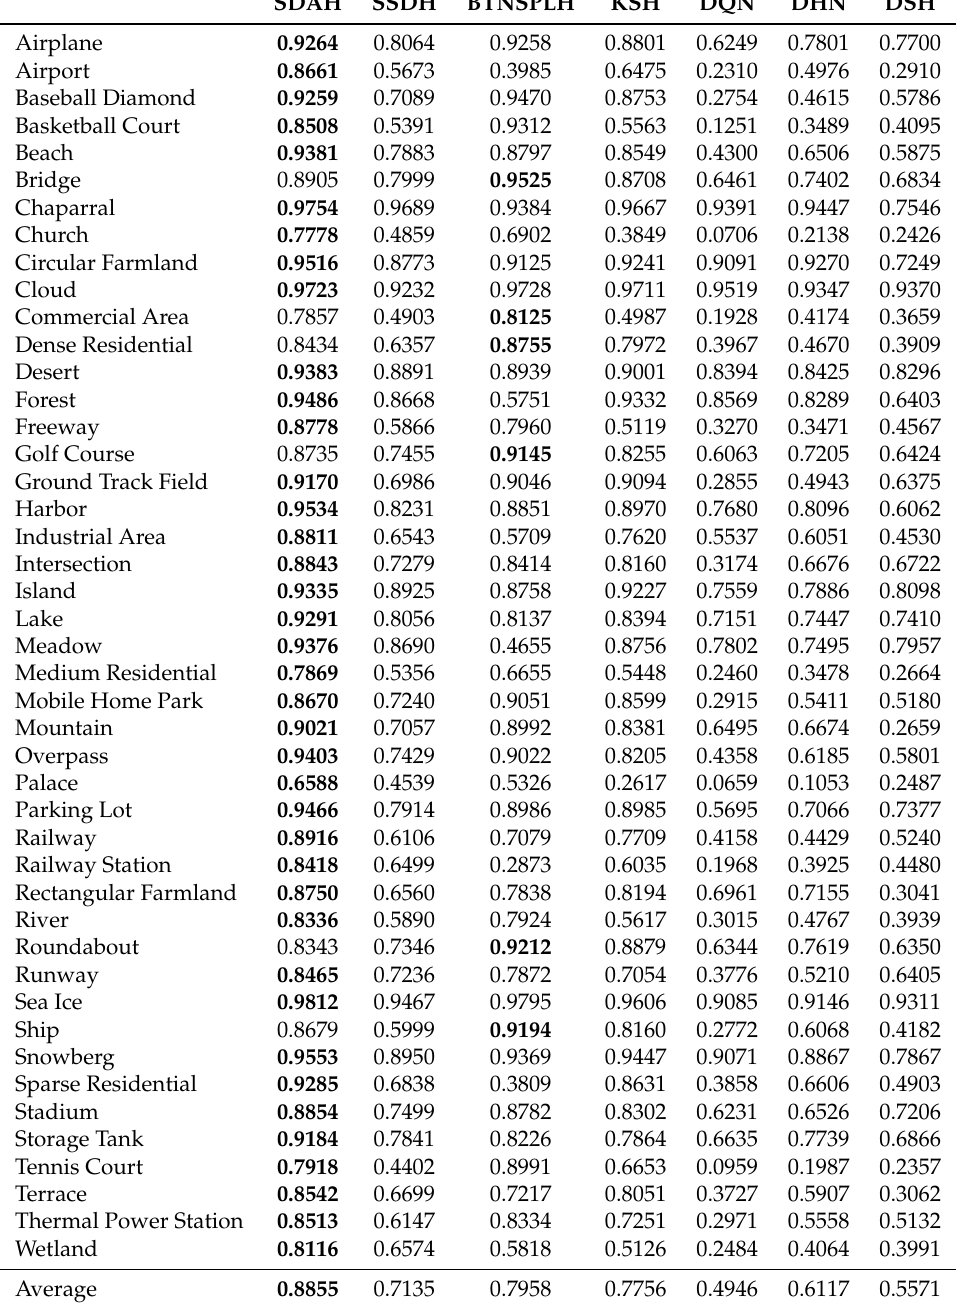
Table 9. Retrieval Mean average precision of different hash learning methods across 45 semantic categories in NMPU archive counted by Top 50 results. The retrieval results are obtained by the hash codes with 128 bits. The values in bold mean that highest mean average precision of different